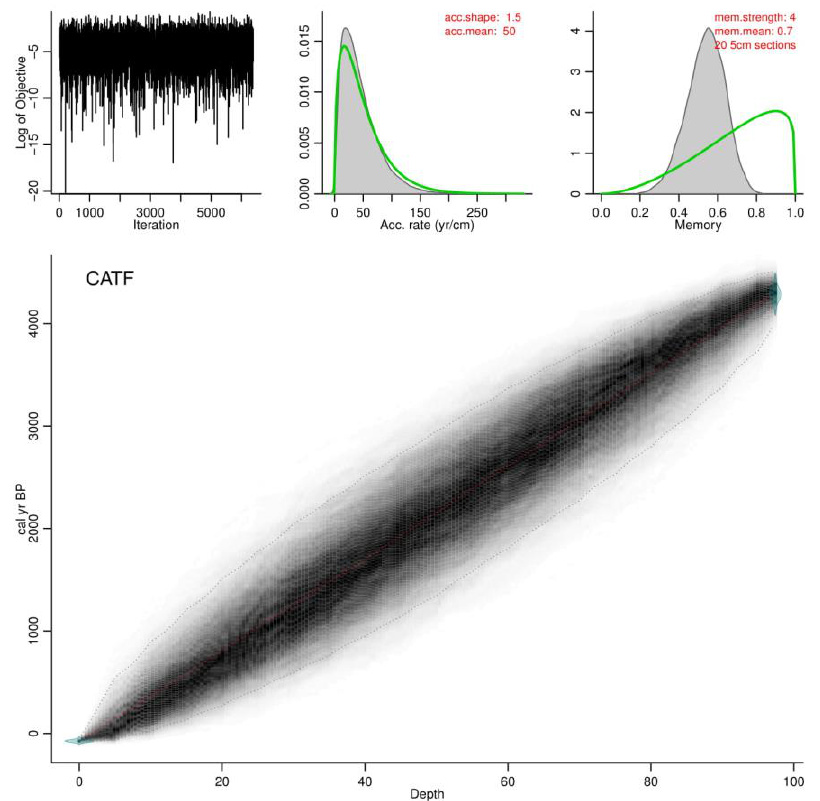
Figure A3e. Age-depth model produced in BACON for CATF.